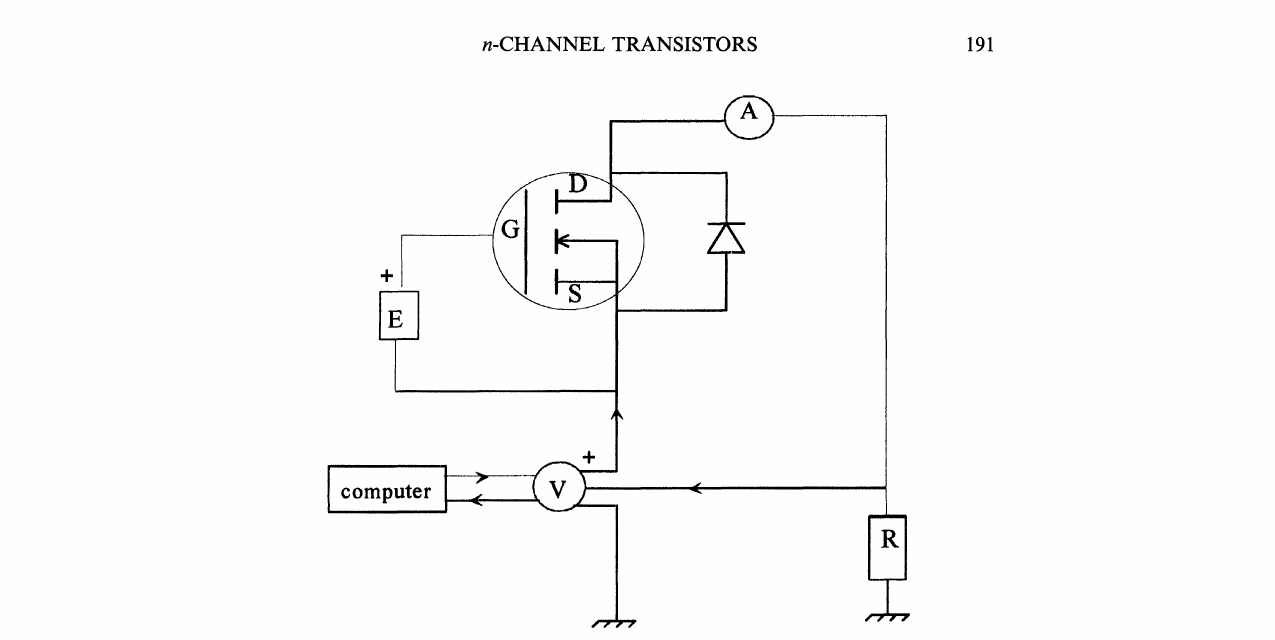
FIGURE Experimental set-up for static measurements of the forward I-V characteristic of the body-drain diode of a n channel HEXFET. The gate voltage is used to control the body-drain diodes through reduction of the effective diode